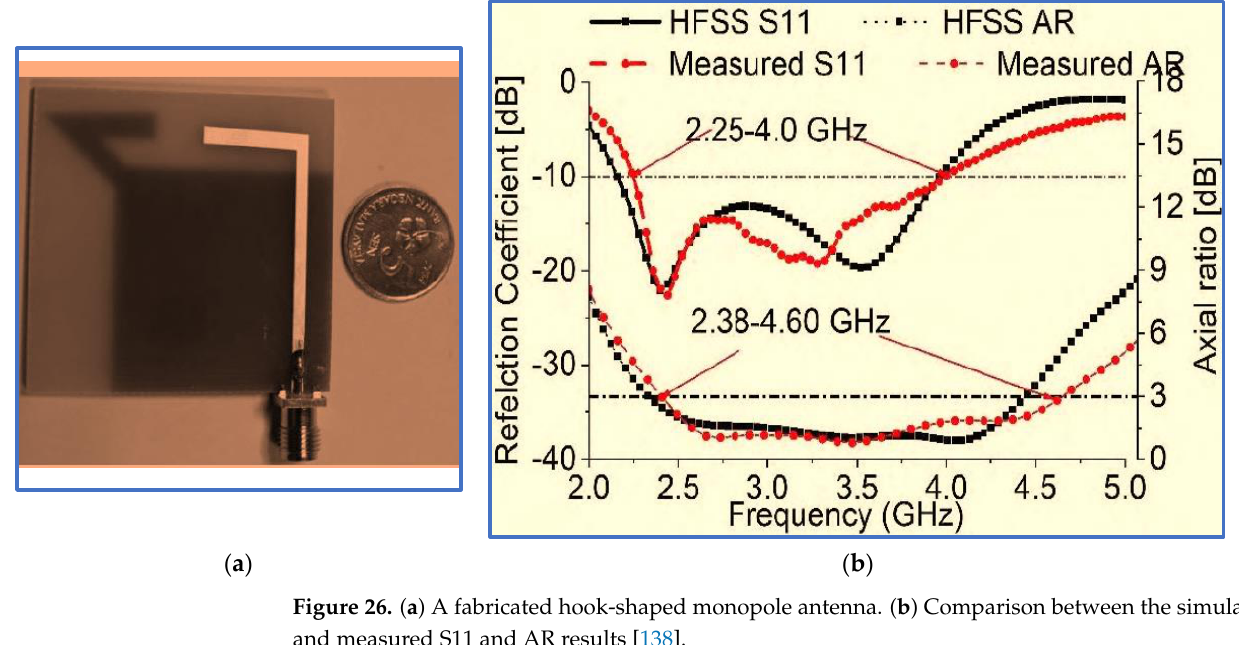
Figure 26. ( a ) A fabricated hook-shaped monopole antenna. ( b ) Comparison between the simulated and measured S11 and AR results [138].